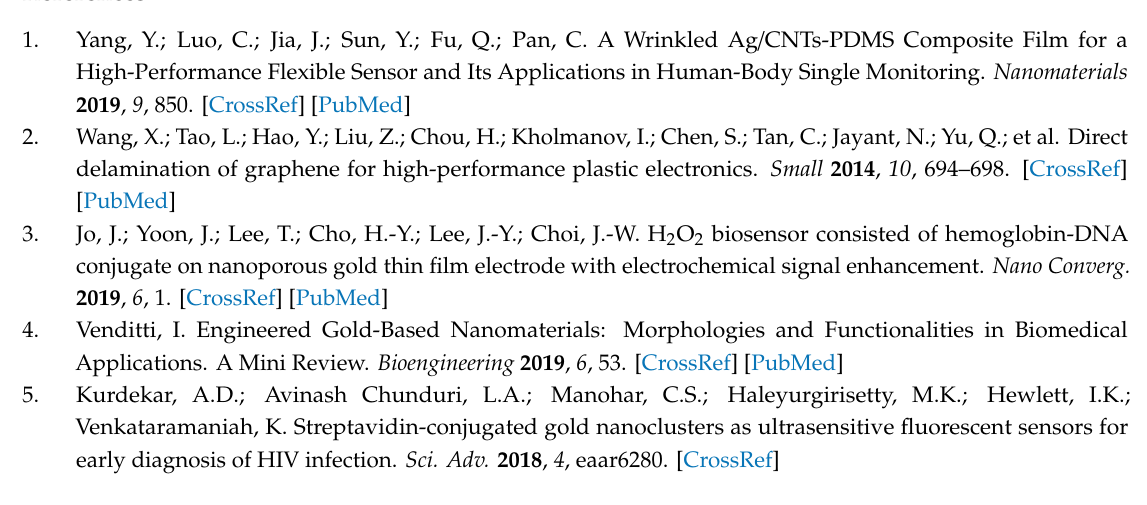
Figure S1: TEM and EDS analysis of MoS 2 NPs. Figure S2: SEM and EDS analysis of ( a ) Au sputter coated PET substrate, ( b ) the Au / MoS 2 on the PET substrate and ( c ) the Au / MoS 2 / Au nanolayer on the PET substrate. Figure S3: EDS mapping results of the Au / MoS 2 / Au nanolayer on the PET substrate. Figure S4: The reproducibility of reduction peaks of the Au / MoS 2 / Au nanolayer on the PET substrate, Cys / Au / MoS 2 / Au nanolayer on the PET substrate and Ab / Cys / Au / MoS 2 / Au nanolayer on the PET substrate. Error bars indicate the standard deviations of four di ff erent measurements. Figure S5: Reduction peak currents of the 10 ng / mL of gp120 antigen on the Ab / Cys / Au / MoS 2 / Au nanolayer on the PET substrate before bending and after bending. Error bars indicate the standard deviations of four di ff erent